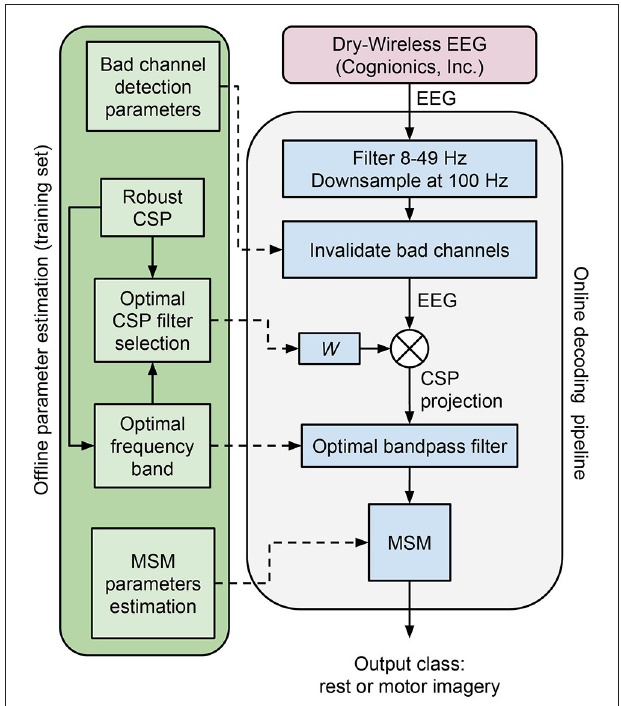
FIGURE 3 | Decoding pipeline. The green box on the left side represents the steps during offline parameter estimation executed on the training set. The blue box on the right is the online decoding pipeline, that uses the parameters estimated